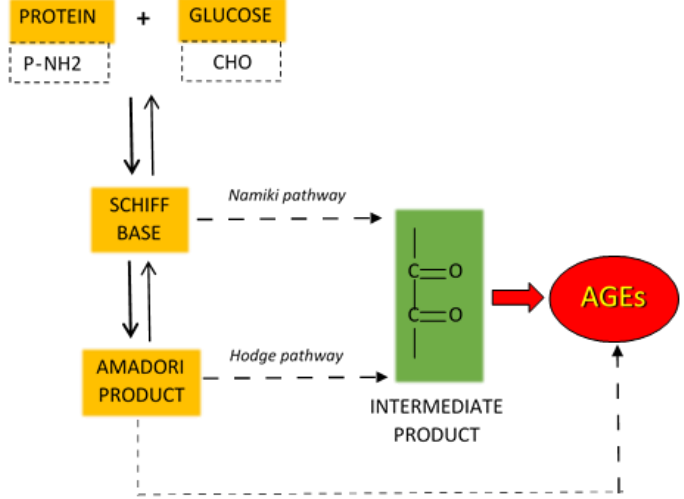
Figure 5. Maillard reaction. Carbonyl groups of glucose react with amino groups of proteins (both in dotted frames) to form Schiff bases (yellow) which then are spontaneously converted to Amadori products (yellow). Both of them contribute to formation of low molecular weight reactive dicarbonyls (intermediate products, green) which bind to proteins forming advacned glycation end products (AGEs, red). Continuous and dotted arrows represent one- and multiple-step reactions, respectively.